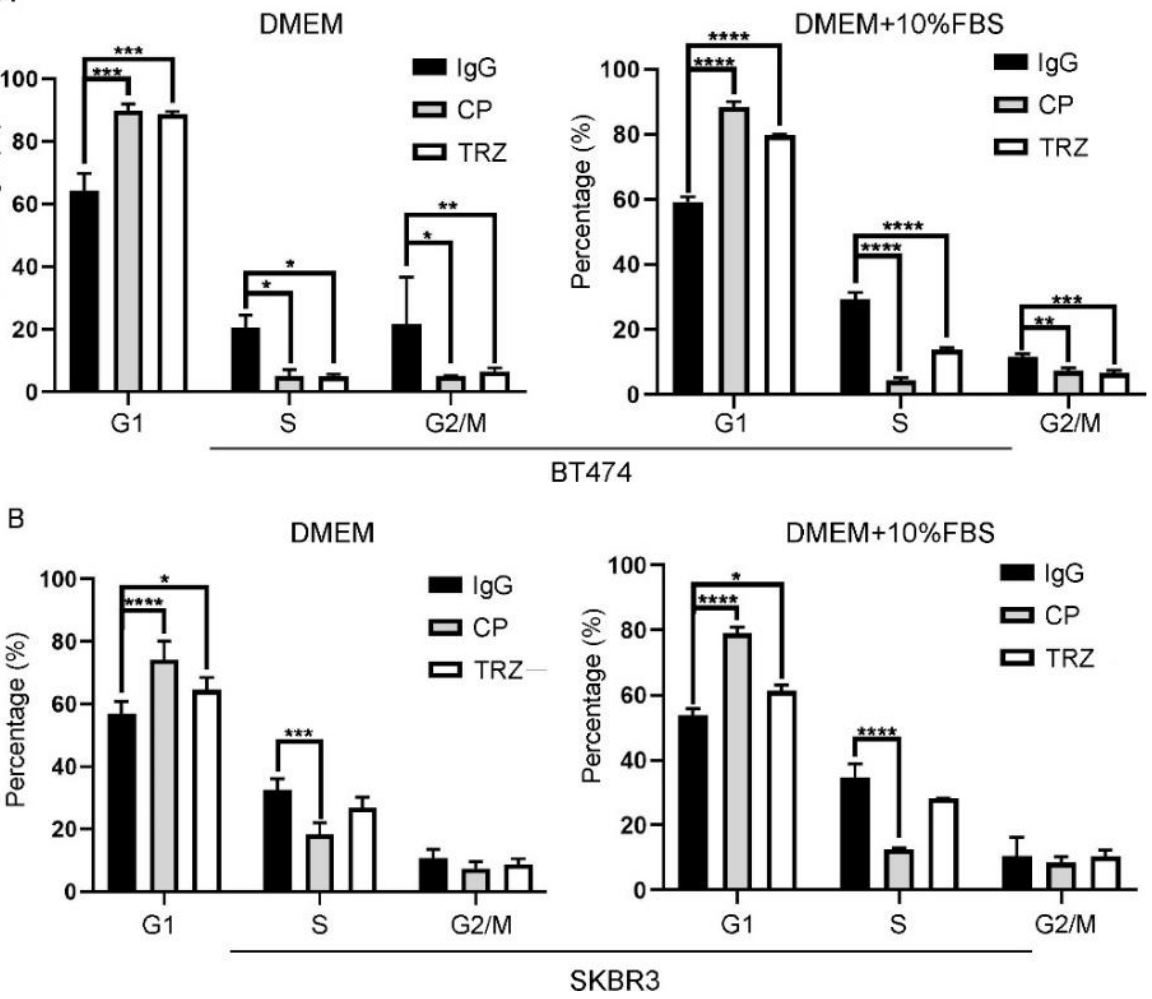
Figure 2. The effects of trastuzumab (TRZ) on the cell cycle progression of BT474 ( A ) and SKBR3 ( B ) cells in presence and absence of 10% FBS. Cells were treated with 10 µg/mL concentration of trastuzumab for 72 h. Cells treated with normal human IgG were used as negative control and cells treated with CP-714724 (CP) at 1 µM concentration were used as positive control. Each value is the average of at least three experiments and the error bar is standard error. *: p < 0.05, **: p < 0.01, ***: p < 0.001, ****: p < 0.0001.